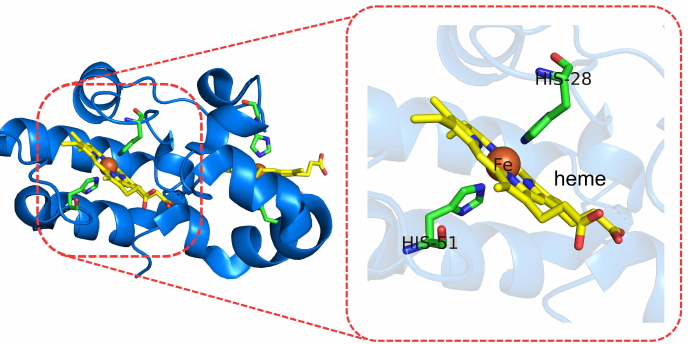
Figure 5. Crystal structure of diheme cytochrome c (DHC) from Rhodobacter Sphaeroides (cartoons, left ) and its active site ( right